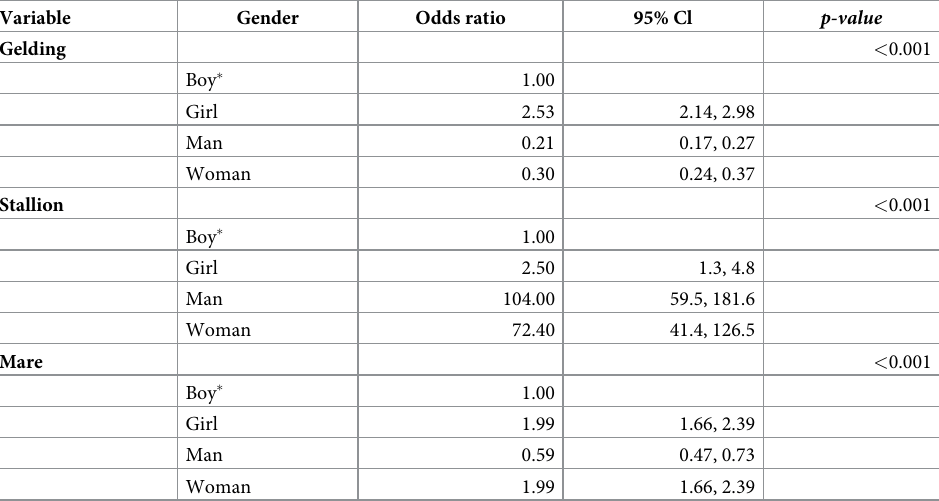
Table 2. Horse allocation odds ratio estimates for geldings, stallions and mares. Variable Gender Odds ratio 95% Cl p-value Gelding < 0.001